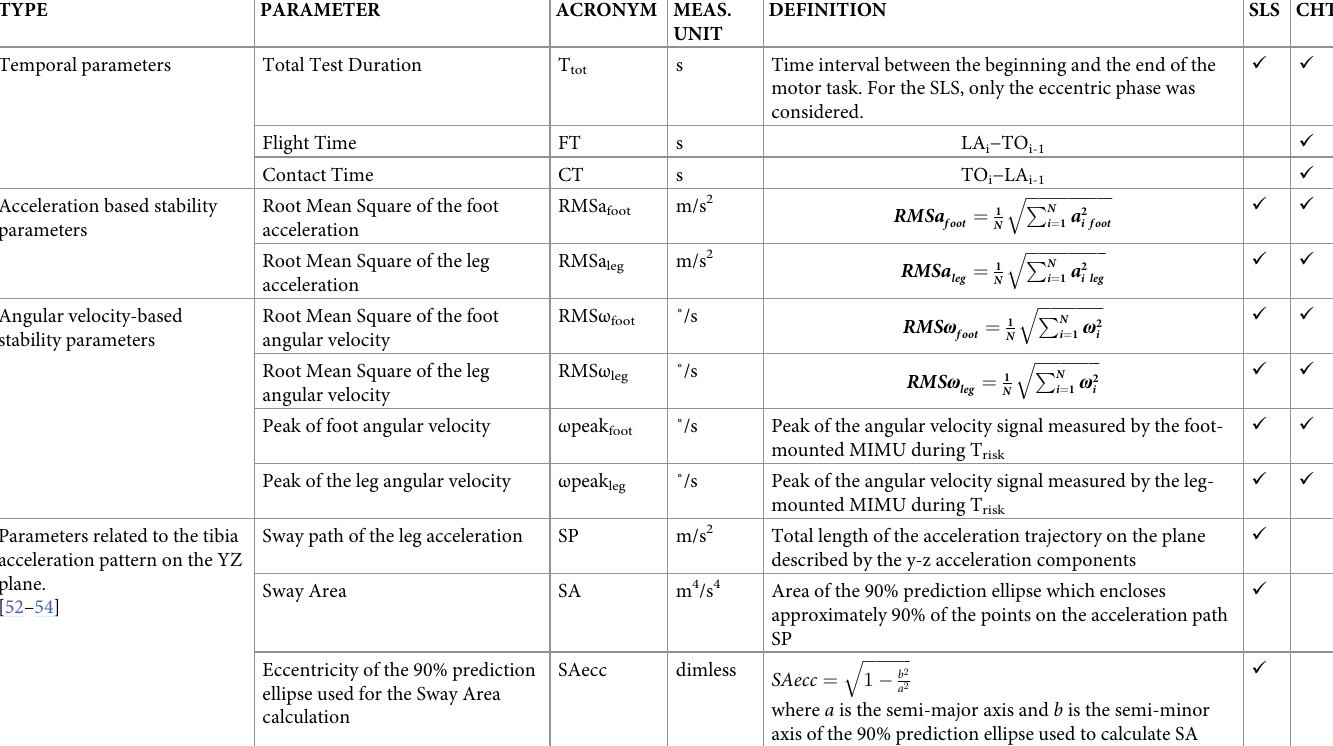
Table 1. List of the MIMU-based parameters estimated for the Single Leg Squat test (SLS) and the Crossover Hop Test (CHT). TYPE